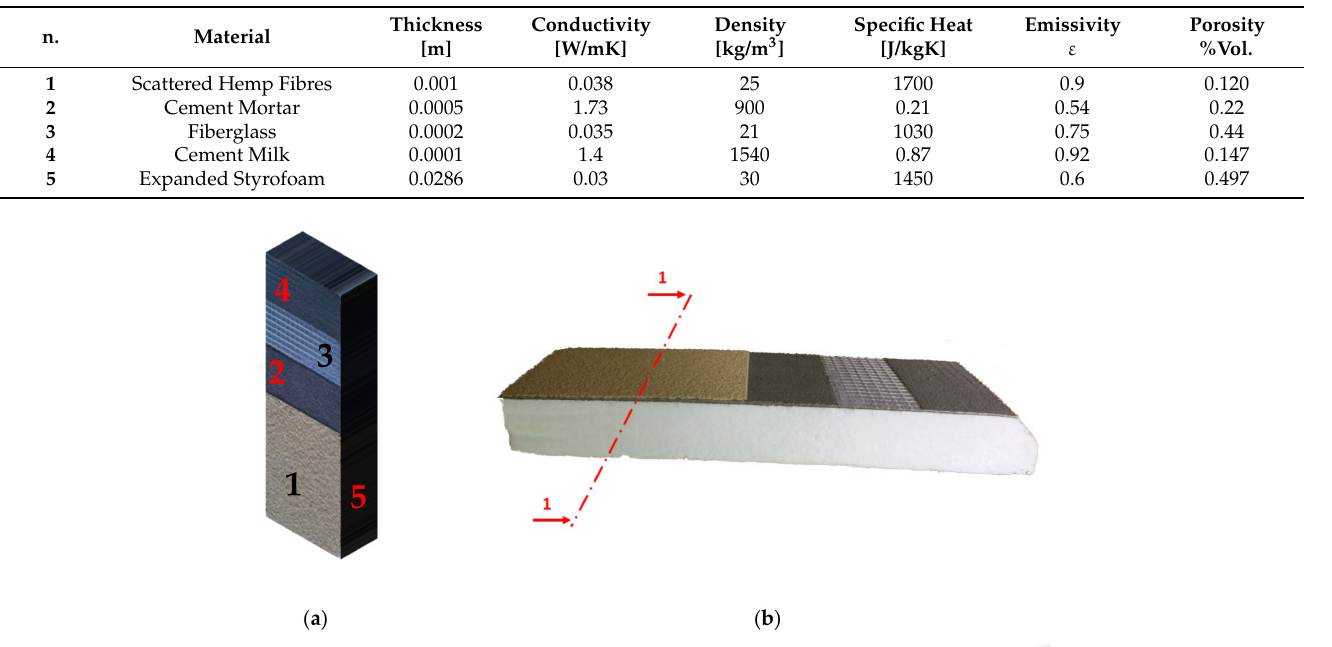
Table 1. Dimensional and thermophysical properties of the materials under analysis.